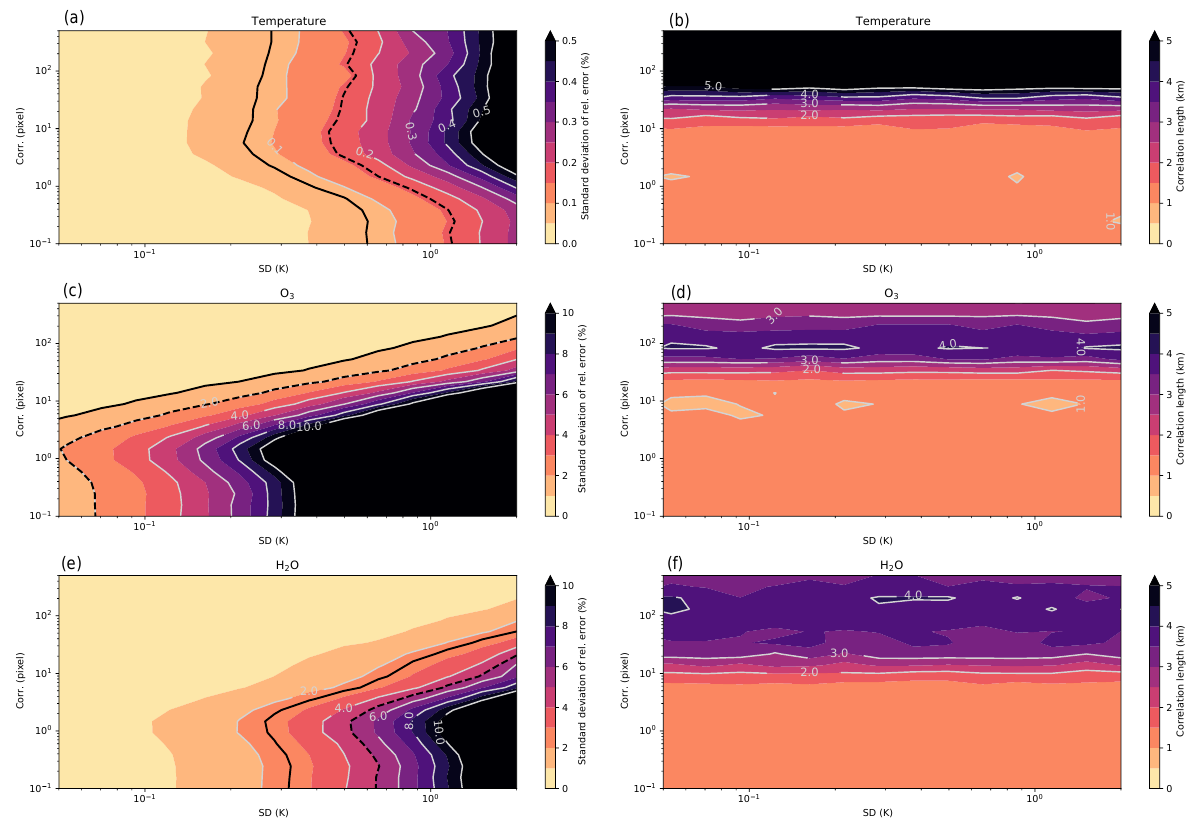
Figure 5. Results of the Monte Carlo approach. Plotted are the standard deviations (a) and correlations lengths (b) of the retrieval error distributions. The x axis shows the standard deviation of the original random variation of the blackbody temperature and the y axis shows the according correlation length. The top row represents the temperature retrieval, in the middle ozone is shown, and the bottom depicts water vapor. The black solid (dashed) line in the left plots indicates the error target (threshold) due to the long-term trend of the respective atmospheric